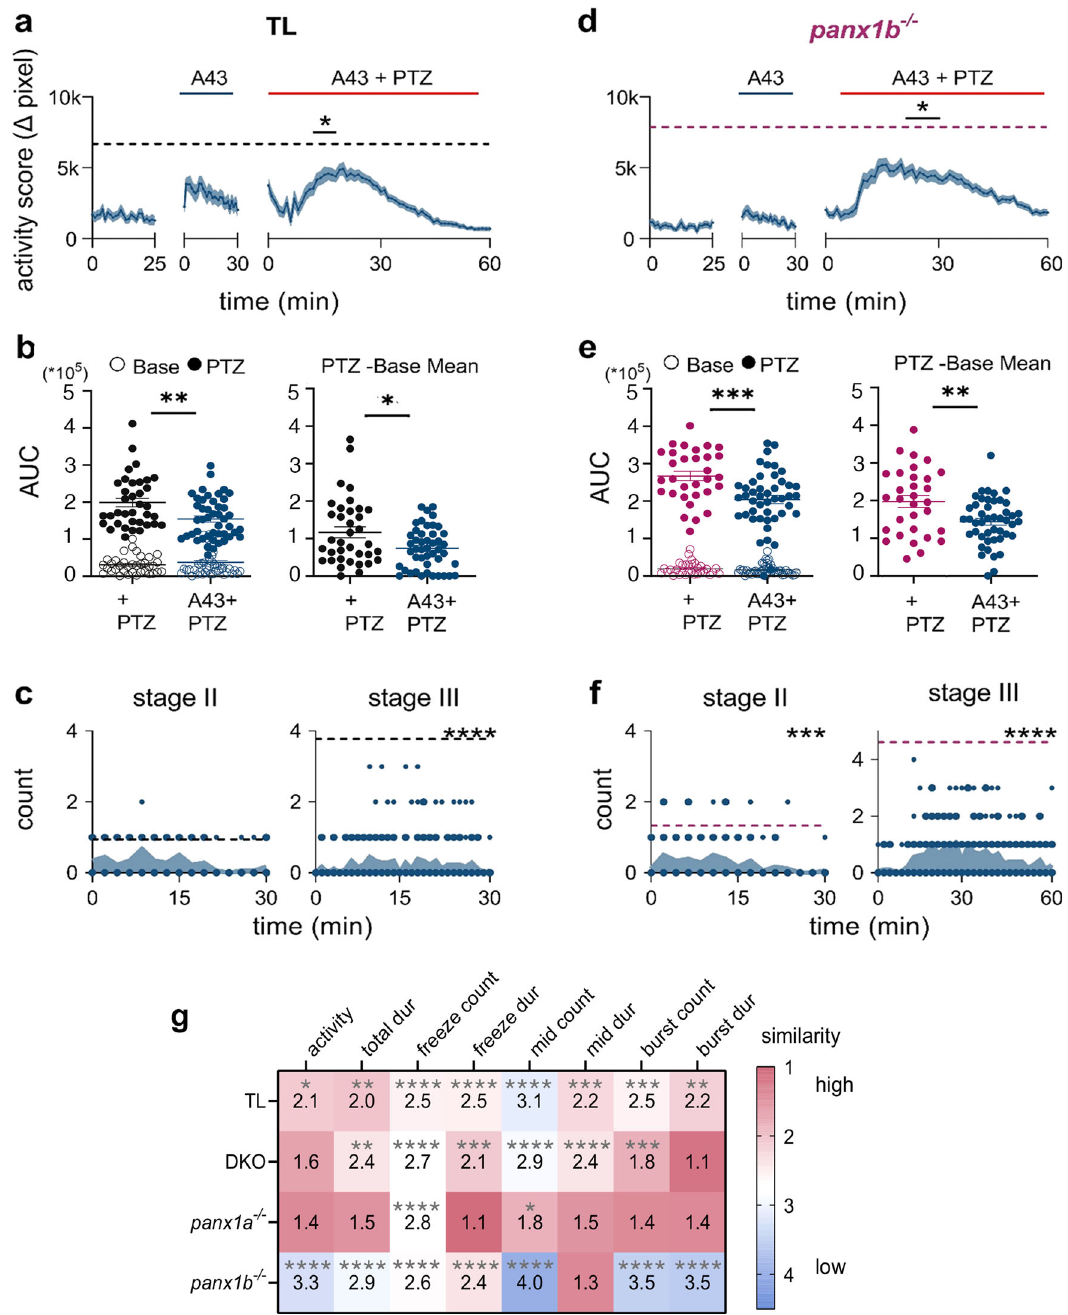
Fig. 8 Blocking of P2rx7 with A-438079 improves seizure-like behavior. a 100 µ M A-438079 (A43) treatment decreased hyperactivity in TL in the fi rst 10 min of PTZ treatment ( Δ pixel ± s.e.m.; n = 46; P = 2.1 × 10 − 3 ). The dashed gray line indicates TL ’ s max average activity score treated with only PTZ ( n = 36). b AUCs for TL ’ s baseline activity and A43 treatment did not differ (open points; P = 0.9). A43 treatment signi fi cantly reduced the effect of PTZ without ( fi lled points; P = 2.4 × 10 − 3 ) and with ( P = 4.5 × 10 − 2 ) extracted baseline activity. c Stage III count (count/2 min) was signi fi cantly reduced with A43 treatment in TL ( n = 18; P = < 1.0 × 10 − 4 ). Dashed lines represent max average Stage II and Stage III counts for TL ’ s PTZ-only group. d A43 treatment decreased PTZ-induced hyperactivity in panx1b − / − ( n = 46; P = 4.0 × 10 − 4 ). The dashed magenta line indicates panx1b − / − ’ s max average activity in the PTZ only group ( n = 31). e A43 treatment signi fi cantly reduced the effect of PTZ in panx1b − / − without ( fi lled points; P = 5.0 × 10 − 4 ) and with ( P = 8.7 × 10 − 3 ) extracted baseline activity. f Stage II and III counts were signi fi cantly reduced with A43 treatment in panx1b − / − ( n = 18; stage II: P = 1.0 × 10 − 4 ; stage III: P ≤ 1.0 × 10 − 4 ). Dashed lines represent max average Stage II and Stage III counts for panx1b − / − ’ s PTZ-only group. g SOM revealed changes to the PTZ phenotype in TL with A43 treatment ( n = 46) for freezing and normal locomotor behaviors ( P < 0.0001). A43 treatment resembled panx1a − / − ‘ s PTZ phenotype the most, and panx1b − / − ‘ s the least, as seen in normal (mid count P < 0.0001) and bursting behaviors ( P < 0.0001). Smaller value and warmer color represent higher similarity. Statistical tests used: Two-way repeated measures ANOVA and Bonferroni multiple comparisons for( a , c , d & f ); Mann – Whitney U test for ( b and e ). Fisher ’ s exact test for ( g ). N = number of larvae. * P < 0.05, ** P < 0.01, *** P < 0.001, **** P <